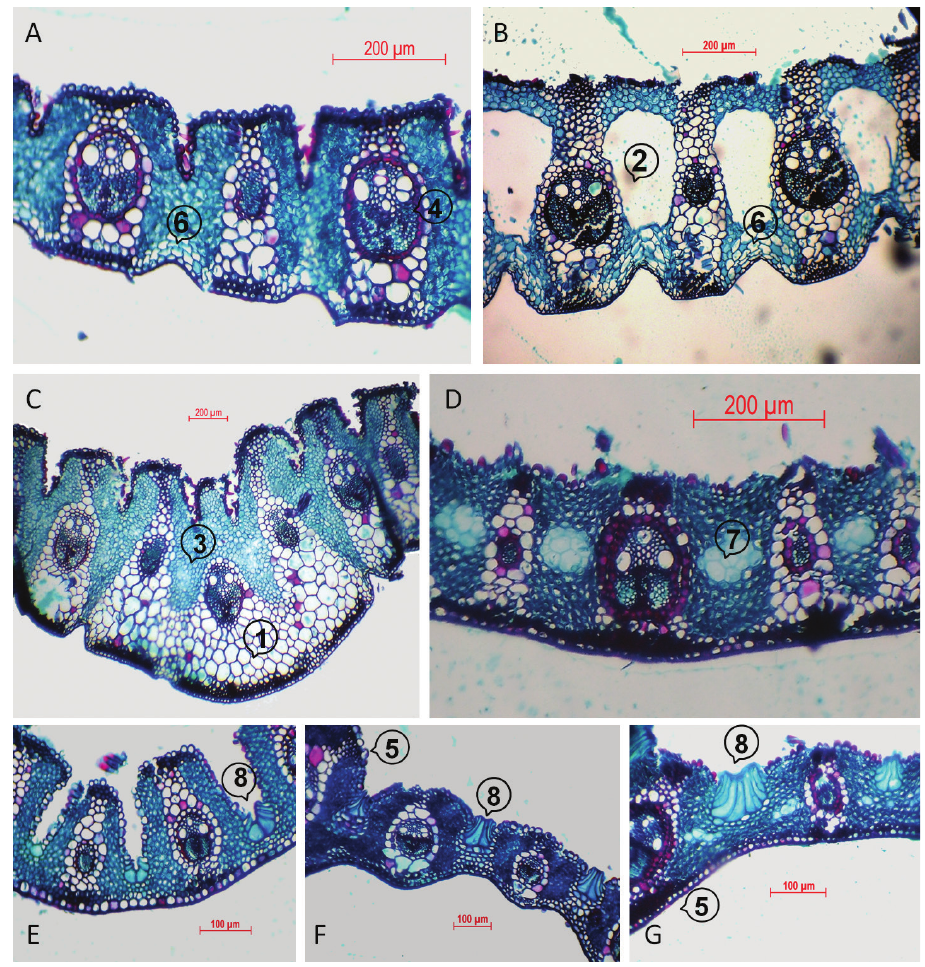
Figure 2. Leaf anatomy of Cortaderia , as evident from transverse sections. A–B C. selloana (Villamil 11738) C C . speciosa (Testoni 644) D C. vaginata (Zanín 1654). Comparison of bulliform cells in Eg- montiana group: E C. egmontiana (Testoni 634) F C. modesta (Carauta 927) G C. vaginata (Zanín 1654). Structures referred to in the descriptions are labelled as follows: 1, multi-layered abaxial sub-epidermal collenchyma layer; 2, aerenchyma; 3, chlorenchyma; 4, primary vascular bundle; 5, midrib; 6, colourless cells; 7, empty cells; 8, bulliform